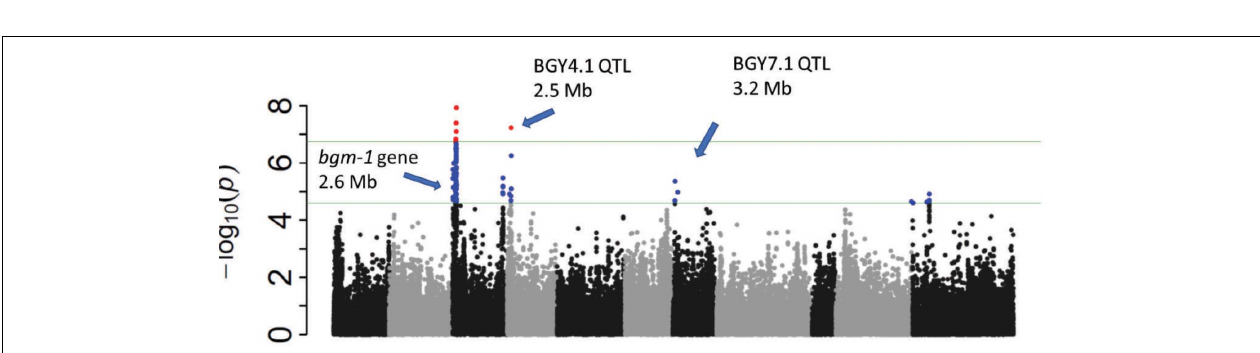
FIGURE 3 | Manhattan and QQ plots from GWAS ( Supplementary Table 3B ) in 412 CIAT breeding lines evaluated (1–9 disease score) in El Salvador (2015). With an LD heat-map view of the significant genomic region from 2.52 to 2.63 Mbp for bgm-1 on Pv03. The positions of candidate genes are shown.